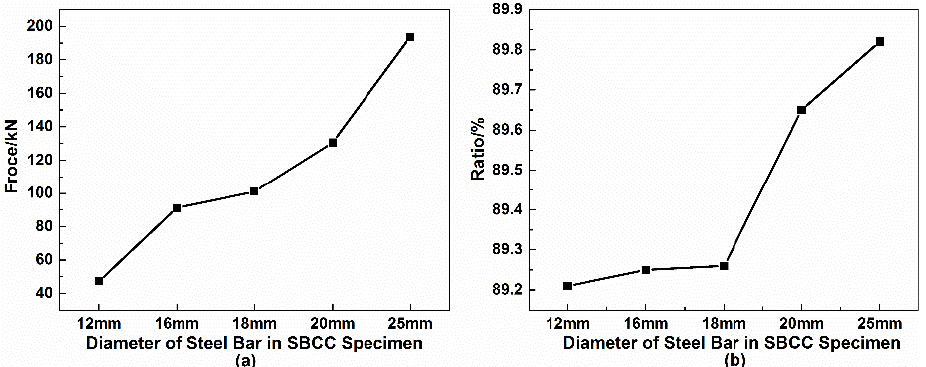
Figure 13. The tensile force corresponding to the maximum extreme point on the By curve in the fixed-point monitoring test, with different steel bar diameters. ( a ) Tensile force corresponding to the maximum extreme point, and ( b ) ratio of the tensile force at the maximum extreme point to the yielding tension.